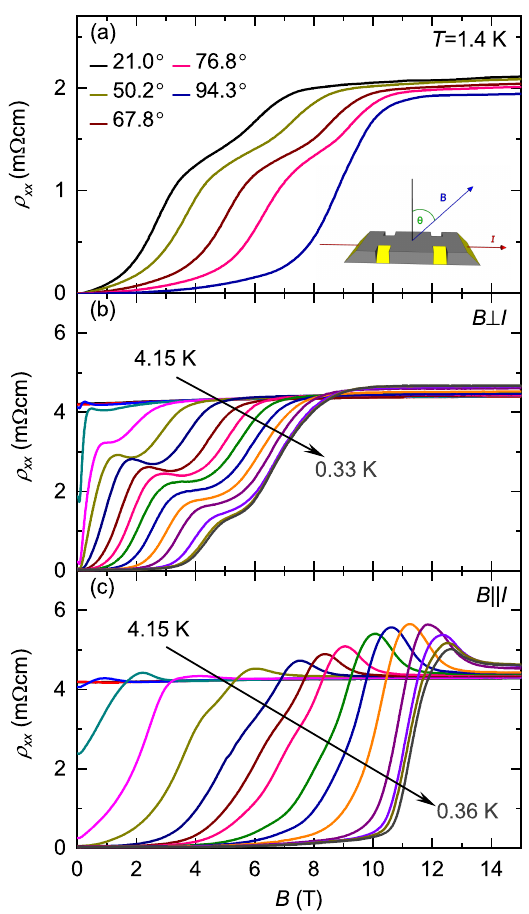
Figure 2. Field sweeps of the resistivity of the FIB-processed sample 4 for ( a ) different angles as defined in the inset and ( b ) different temperatures in a magnetic field parallel to the current direction and ( c ) in a field perpendicular to the